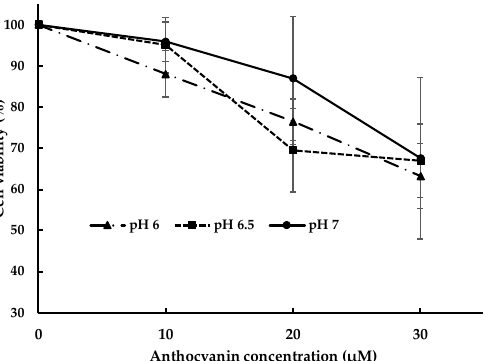
Figure 2. The effect of pH at different anthocyanin concentration on cytotoxicity.